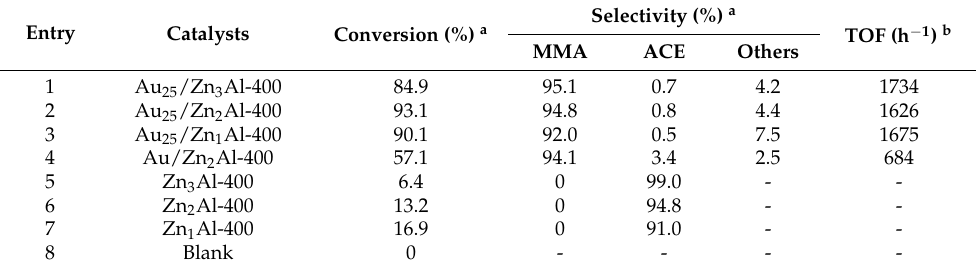
Table 1. Catalytic activities of MAL with MeOH to form MMA over supported gold